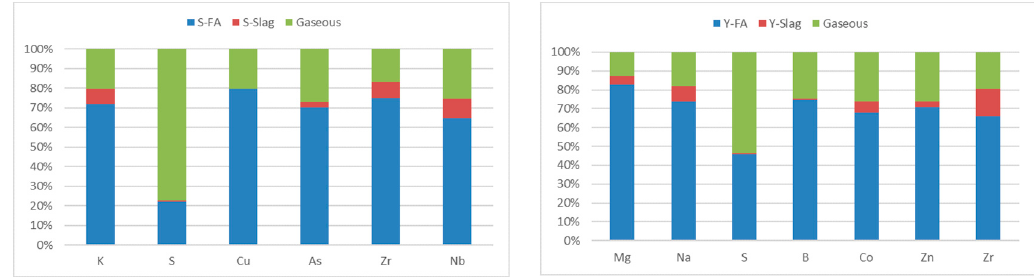
Figure 8. Partitioning for some volatile elements at ESP at Shenhuo ( left ) and Yihua ( right ) power plants.